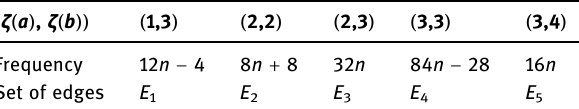
Table 2: Edge partition based on degrees of end vertices of each